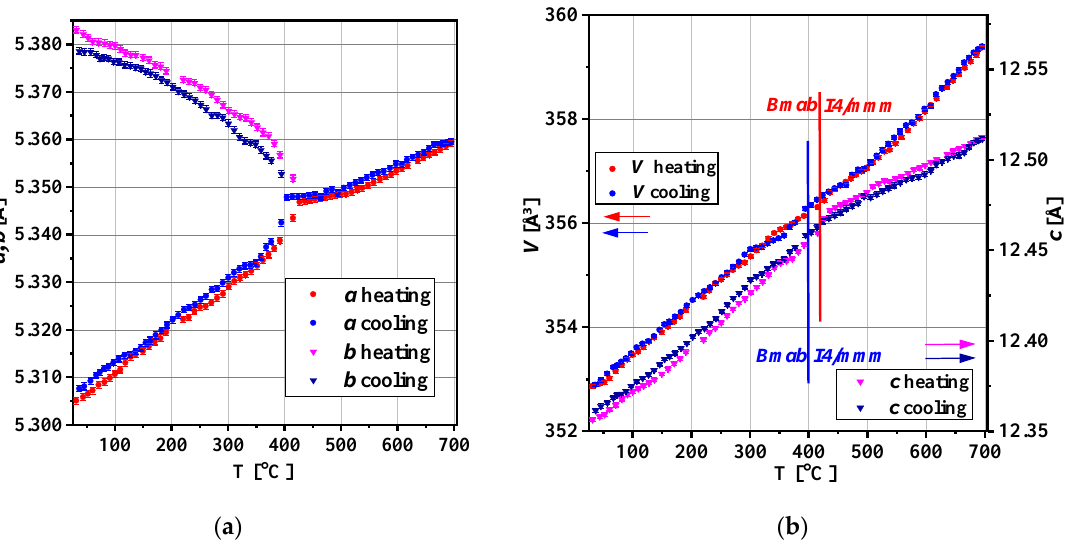
Figure 3. Changes in the a and b lattice parameters upon heating/cooling in the air flow ( a ); the unit cell volume and the c parameter change ( b ) for the NCNCO02 sample. Parameters of the tetragonal structure are given in an unconventional F4/mmm sp.gr. for the direct comparison with those of a Bmab sp.gr.